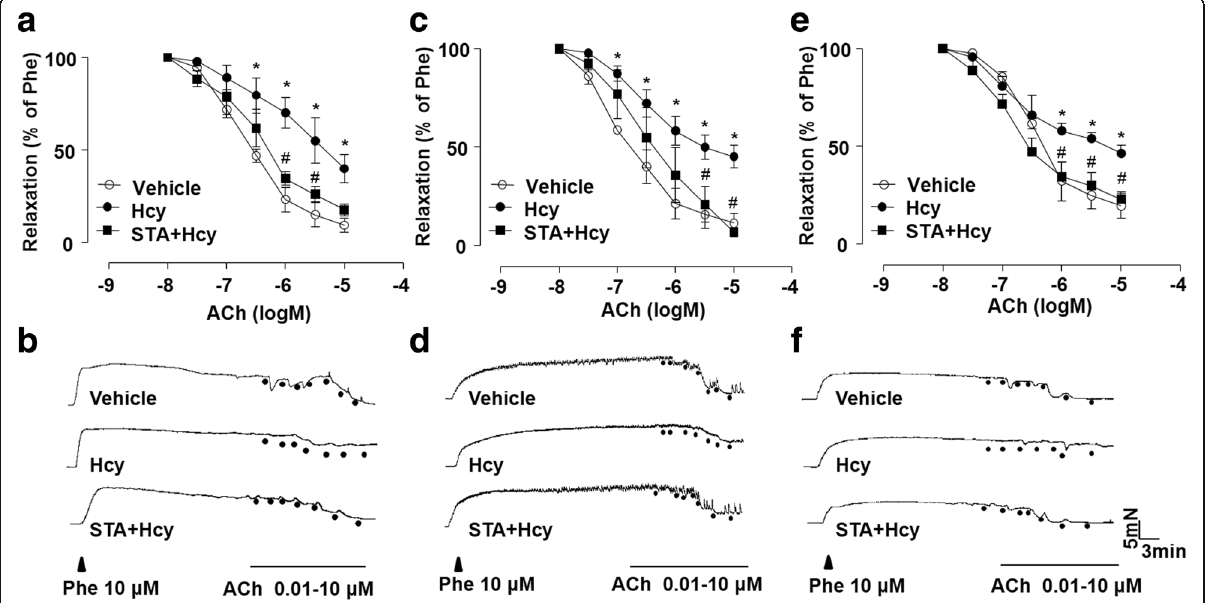
Fig. 1 STA improved Hcy-impaired vascular relaxation. After pre-treatment of TA ( a ), MA ( c ) and RA ( e ) rings with STA (10 μ M, 12 h), the arterial rings were exposed to Hcy (500 μ M, 60 min). The cumulative concentration-response curves for ACh-induced relaxations of the phenylephrine-pre-contracted arterial rings were shown. b , d and f Representative traces of endothelium-dependent relaxations as in ( a , c and e ). Data were shown as mean±SEM; n =5 for each group, * P <0.05 vs. Vehicle; # P <0.05 vs.